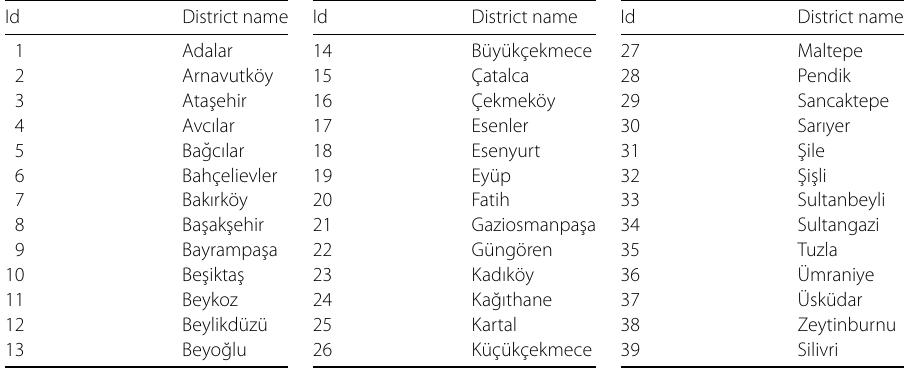
Table 1 Correspondence between district names and